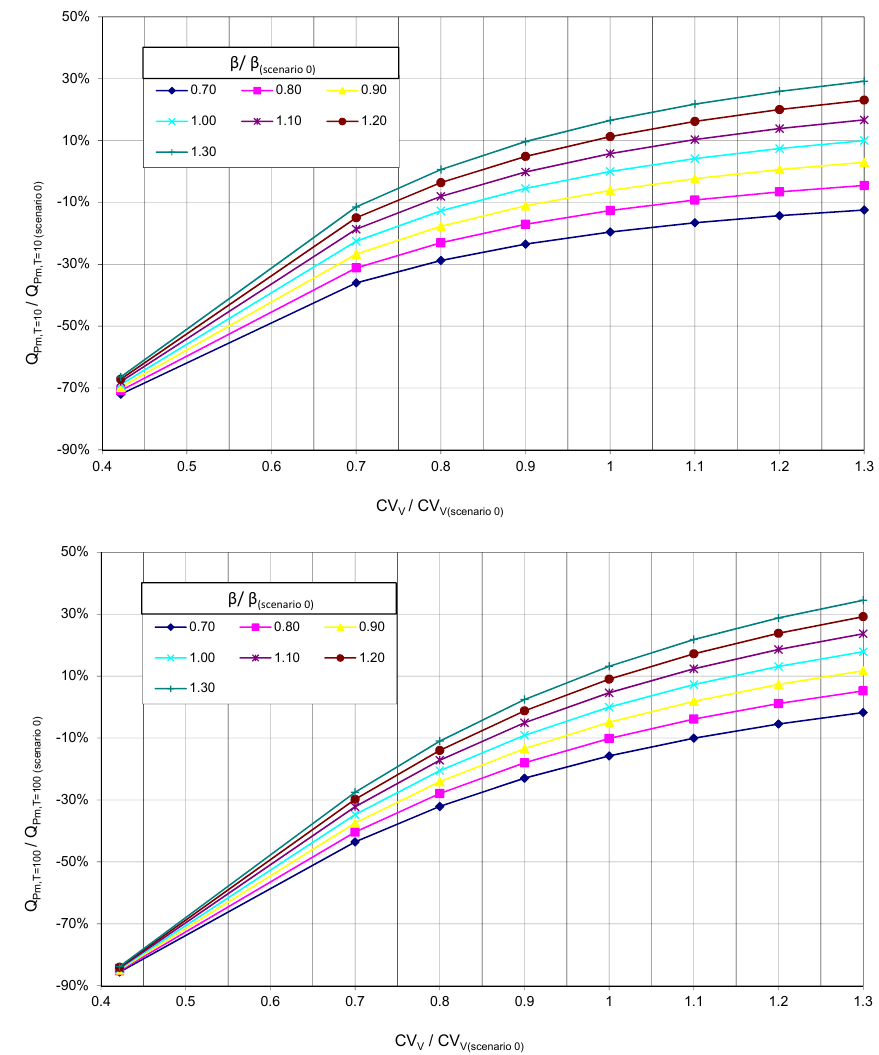
Figure 1. Annual maximum flood quantile variations for changes in β and CV V . Catchment parameters are set to S/µ V = 3.5 and t C = 1h. Cases T = 10 years (top panel) and T = 100 years (bottom